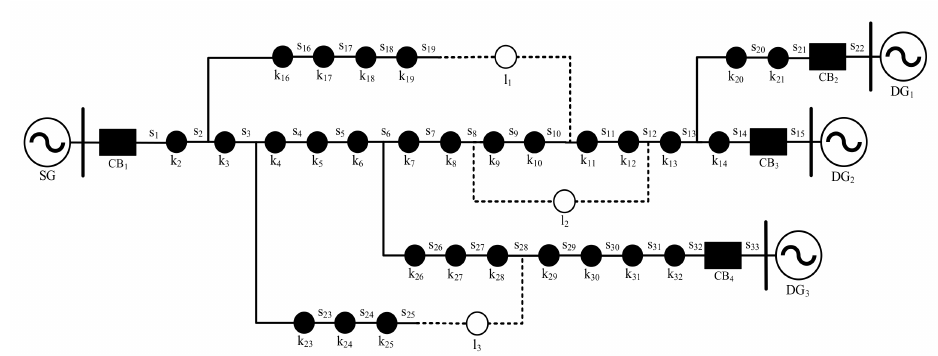
Figure 7. 33-node distribution network simulation model.